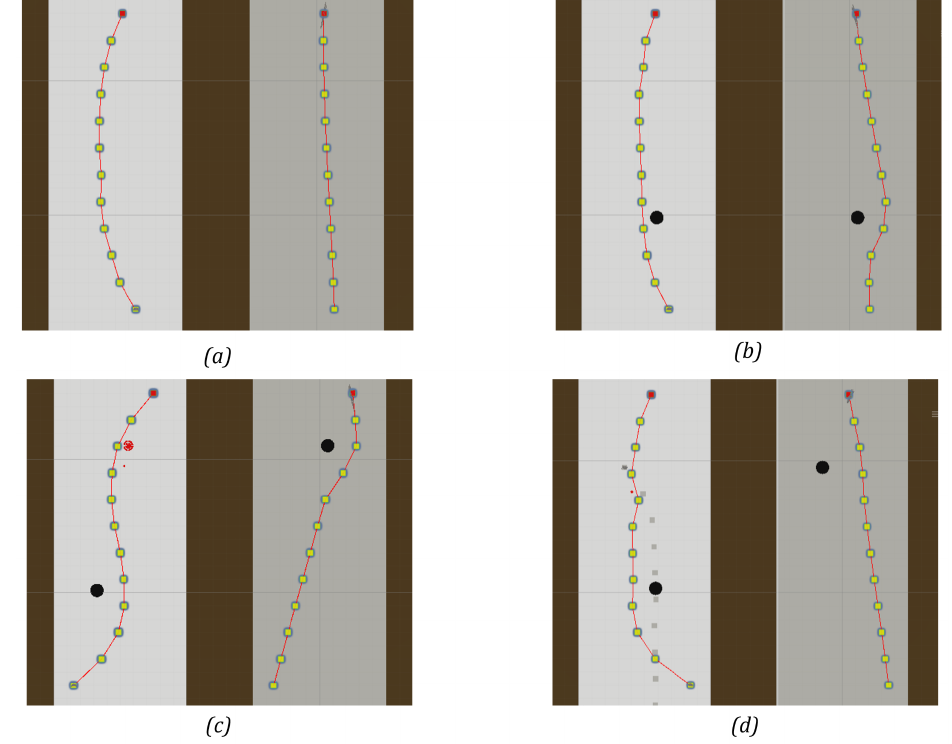
Figure 10. Our model (left) compared with SFM (right) in different situations: ( a ) no obstacle; ( b ) with a static obstacle; ( c ) with a moving obstacle; ( d ) with a pedestrian